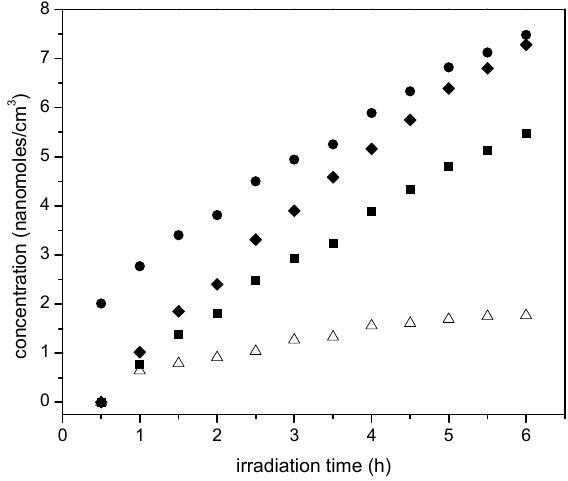
Table 5. Proposed reduction reactions on Pt sites.